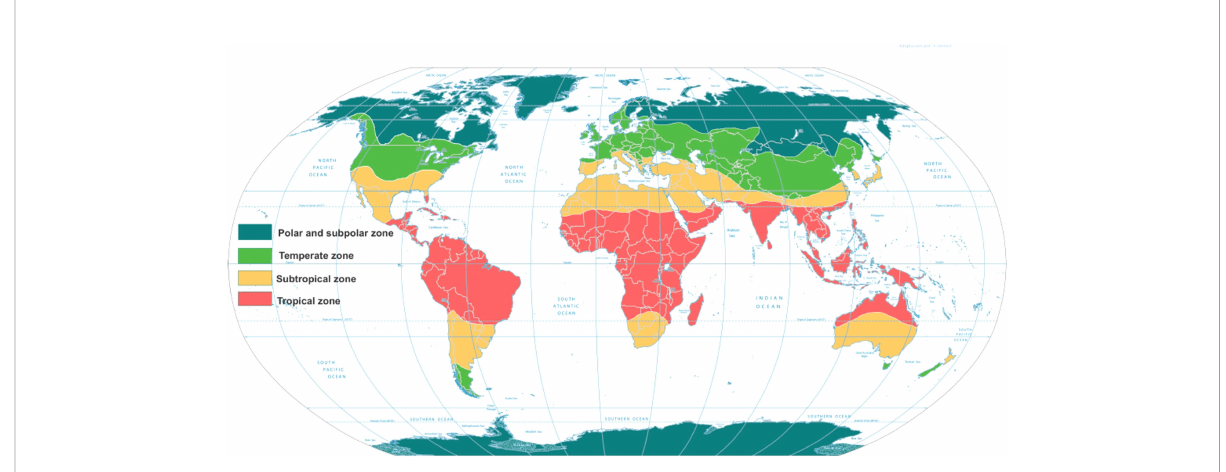
FIGURE 1 World map with the intertropical zone highlighted in red. (https://content.meteoblue.com/pt/research-education/educational-resources/